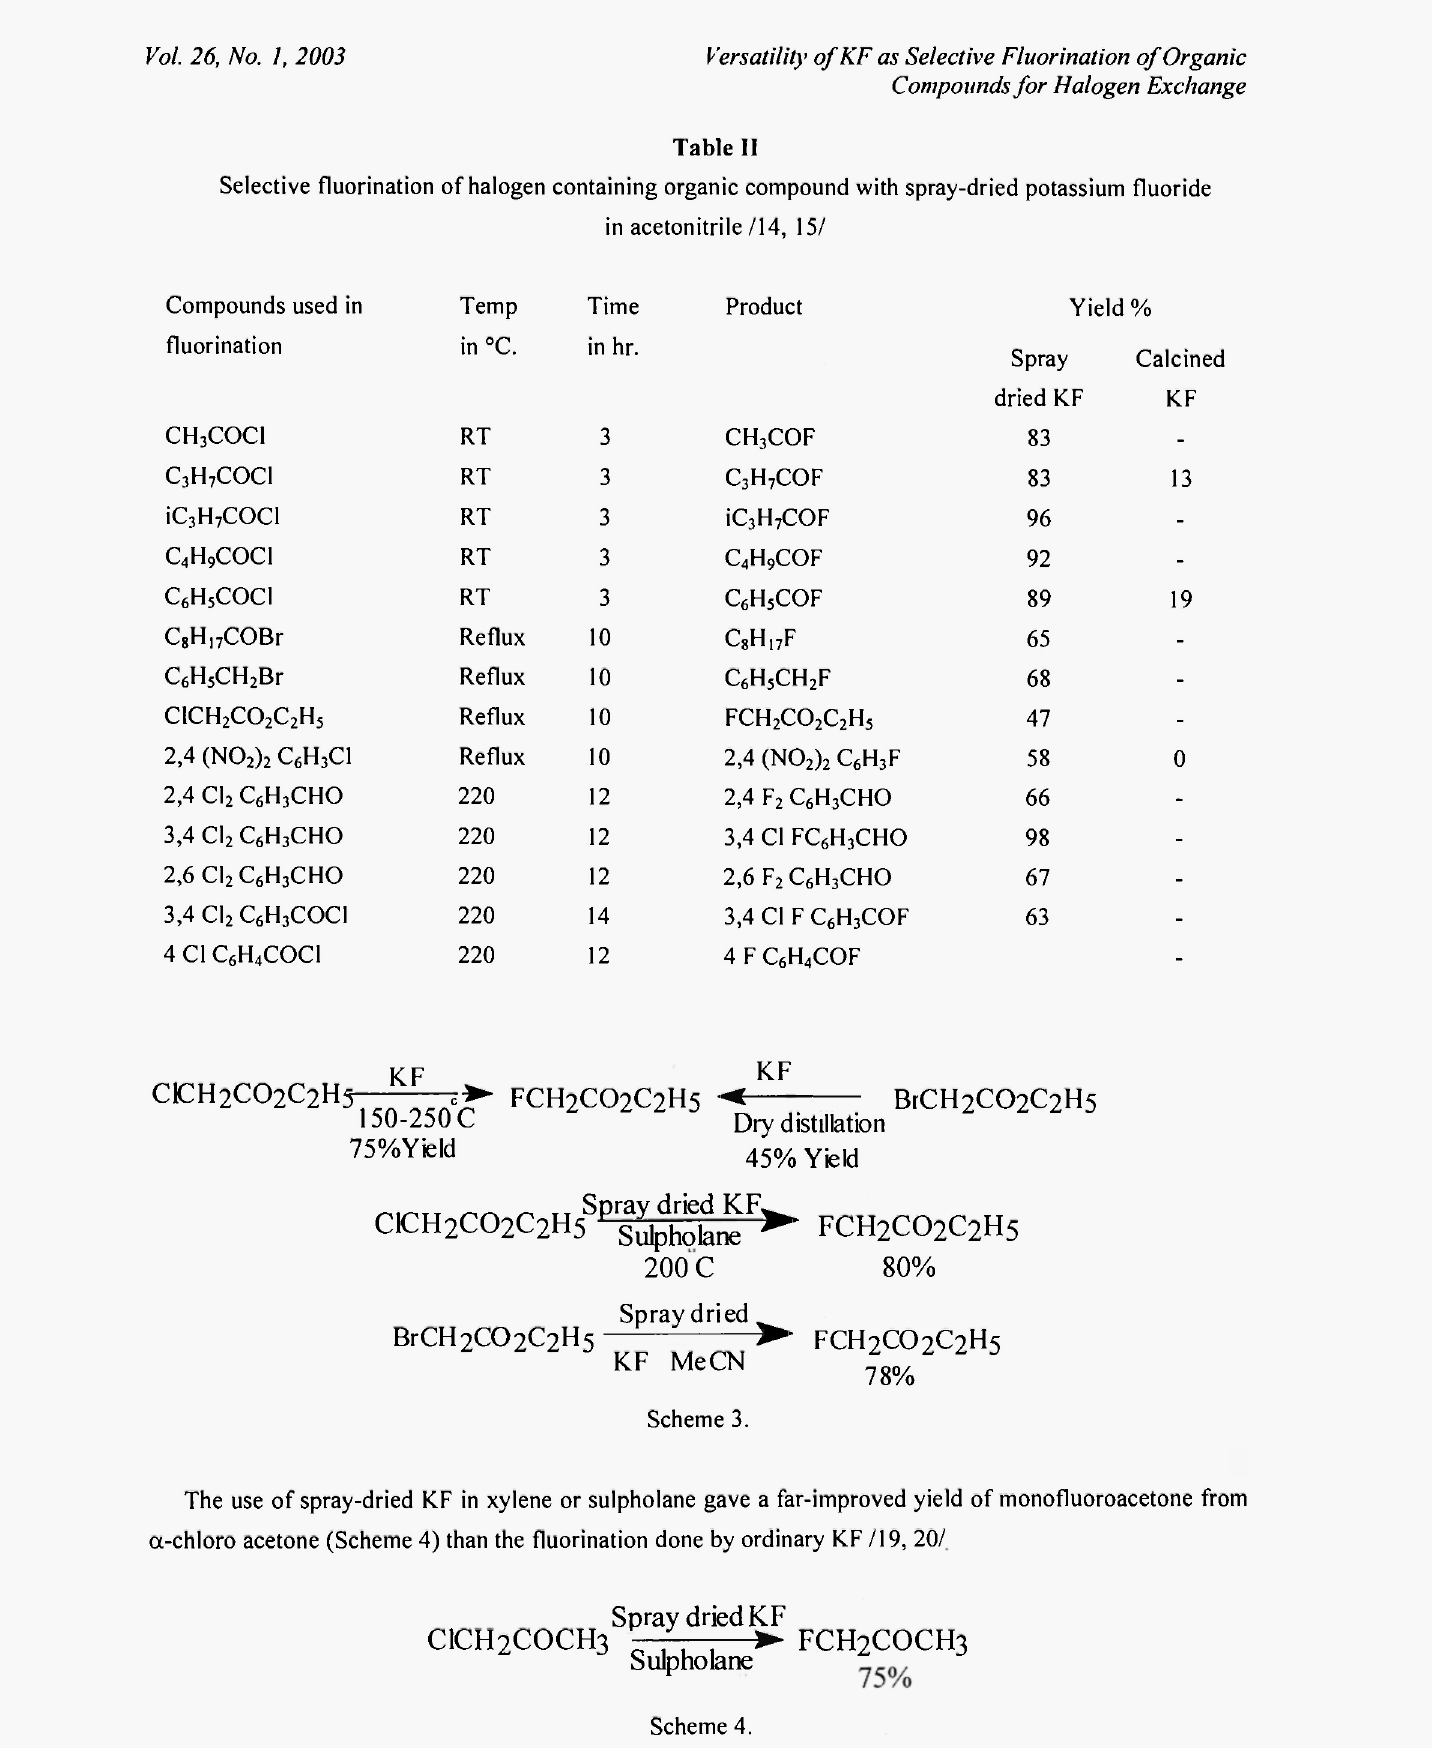
Compounds used in Temp Time